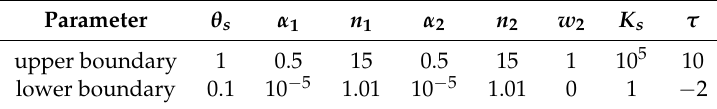
Table 3. Boundaries for parameters of bimodal van Genuchten-Mualem model. Parameters are: α j in cm − 1 , n j and τ , both dimensionless, are fitting parameters; θ s , in cm 3 cm − 3 , is saturated water content; w 2 , dimensionless, is the weight of the second sub-function; and K s in cm day − 1 is saturated hydraulic